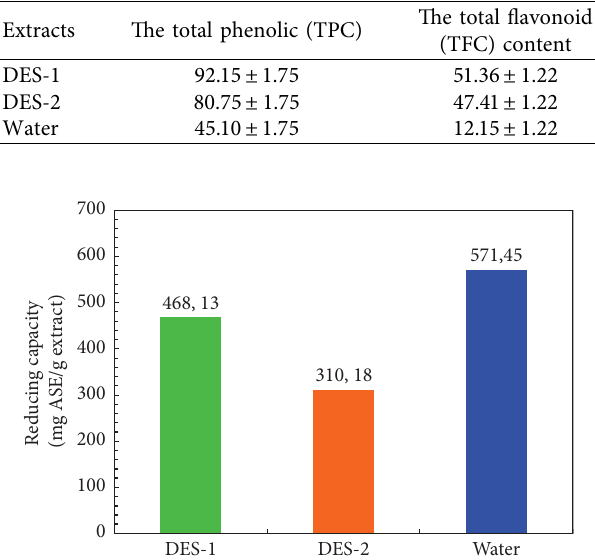
Figure 4: Reducing powers of the grape pomace extracts were evaluated by the phosphomolybdenum